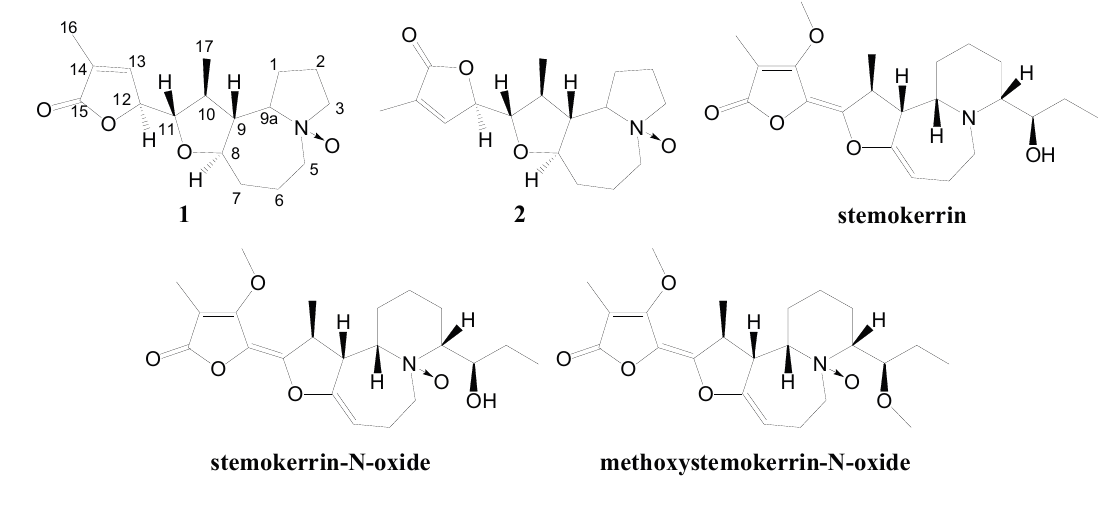
Figure 1. Structures of the isolated